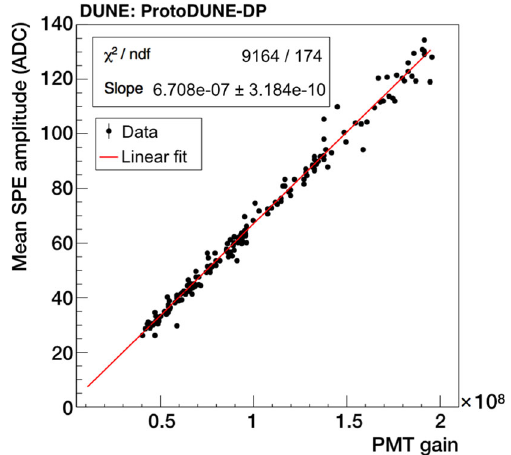
Fig. 9 Example of SPE pulse in a PMT waveform (10 7